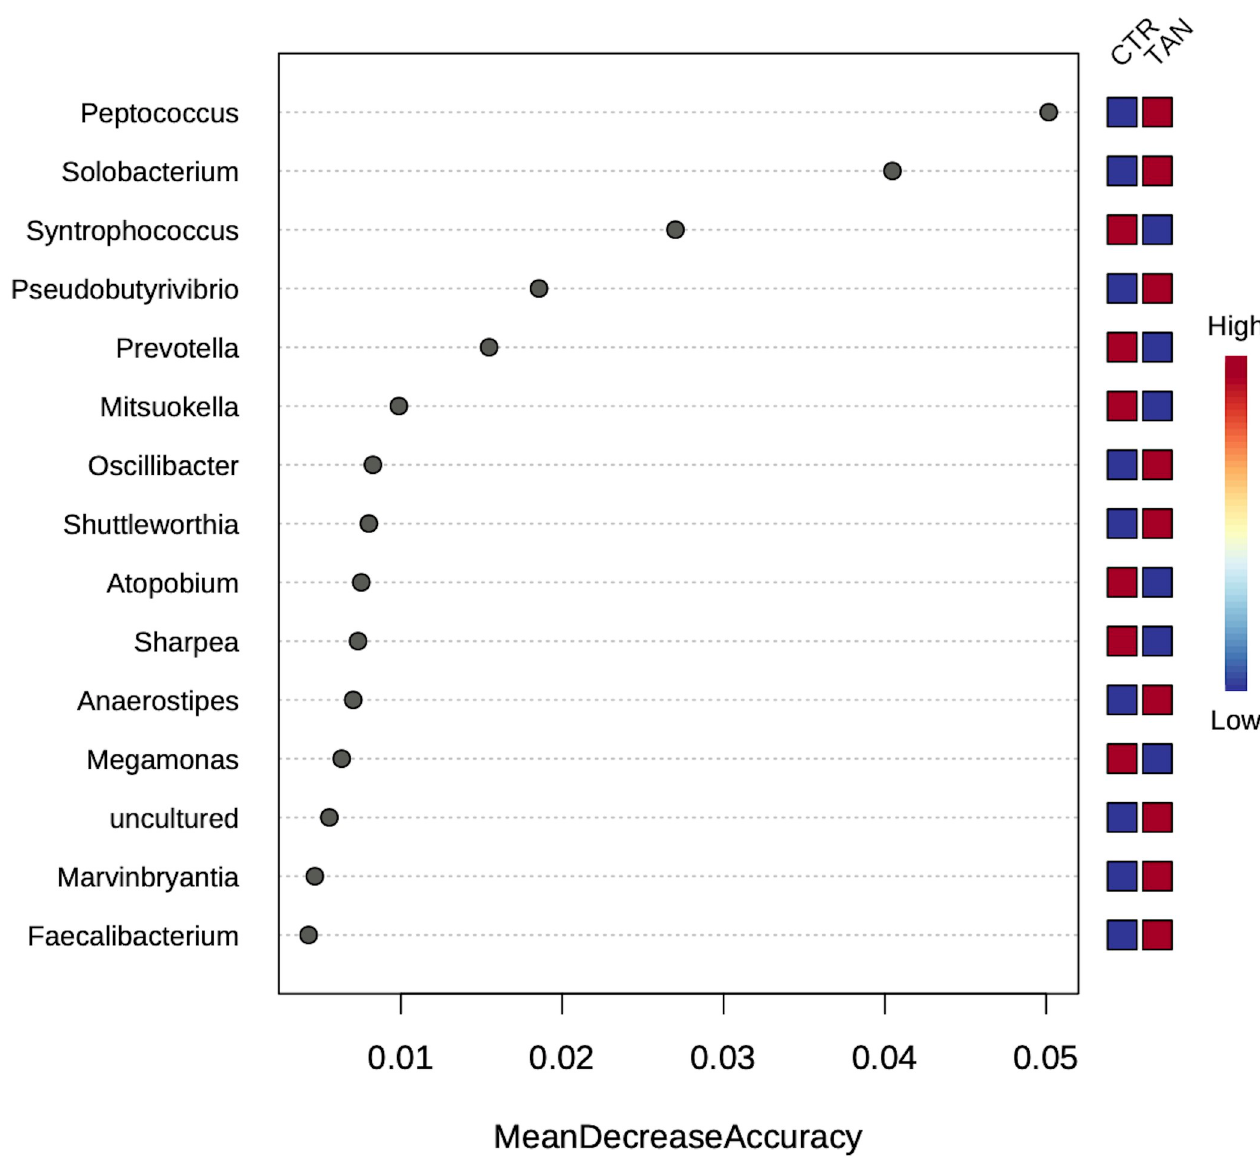
Fig 4. The most discriminant genera between the control- and tannin-sample sequences as sorted by Random Forest analysis using the mean decrease in accuracy.